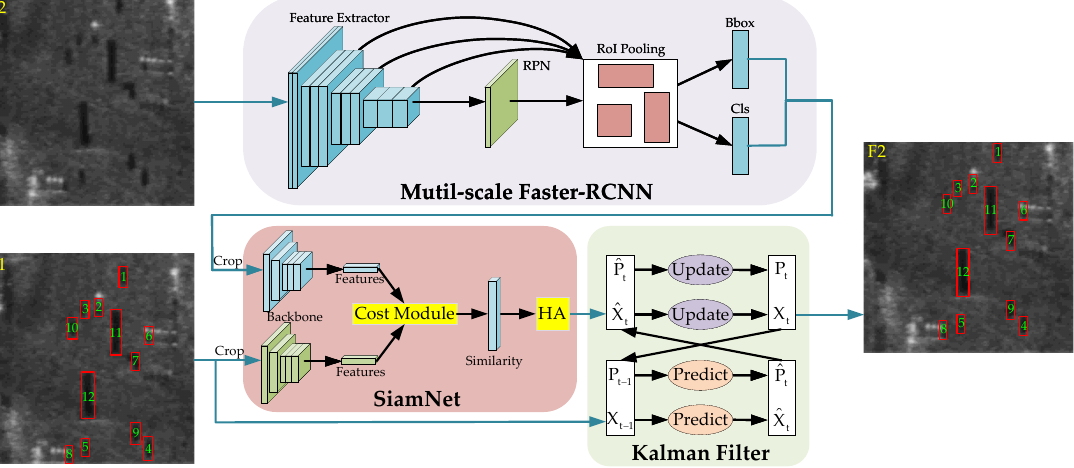
Figure 2. The framework of Siam-sort. The purple area shows multi-scale Faster-RCNN for target detection.The red area shows SiamNet for data association. The green area shows Kalman filter for target tracking. ‘HA’ denotes the Hungarian